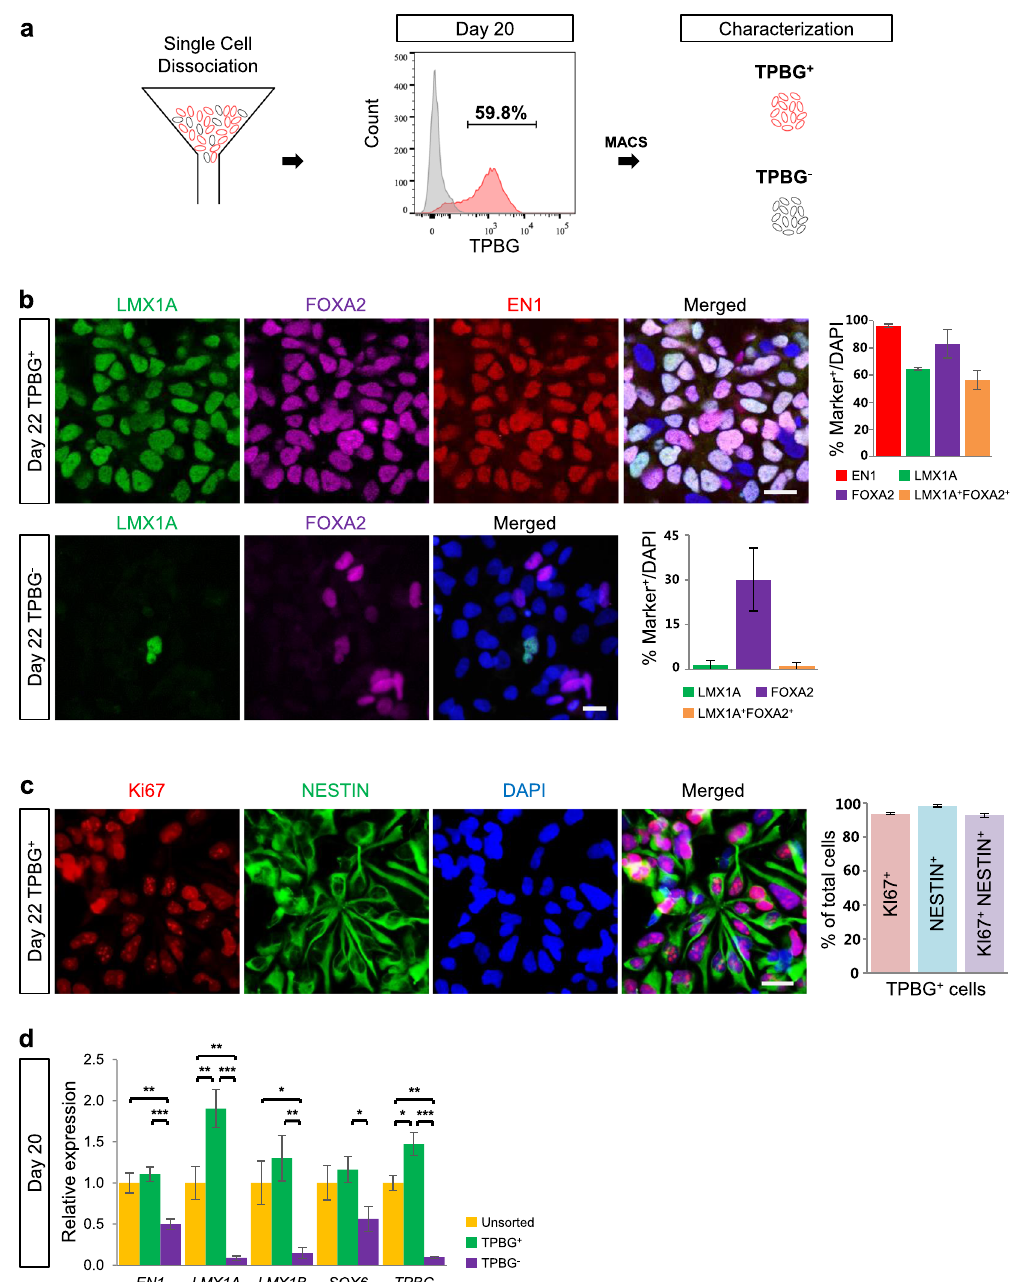
Fig. 3 Characterization of TPBG + cells. a Schematic overview of isolation and characterization of TPBG + cells on D20. b Representative immuno fl uorescence images of TPBG + cells and TPBG − cells expressing LMX1A (green), FOXA2 (magenta), and EN1 (red) two days after MACS. Cells were counterstained with DAPI (blue). The percentages of EN1 + , LMX1A + , FOXA2 + , and LMX1A + FOXA2 + double-positive cells out of the total cell population are shown in the graphs. Data are the mean ± SD of three independent experiments. c Representative immuno fl uorescence images of TPBG + cells targeting Ki67 (red), NESTIN (green), and DAPI (blue) ( left ). The percentages of NESTIN + , Ki67 + , and NESTIN + Ki67 + double-positive cells in the total cell population are shown in this graph. Data are shown as mean ± SD of three independent experiments. d Comparison of relative expression of vmDA lineage markers and regional identity markers (i.e., EN1 , LMX1A , LMX1B , and SOX6 ) on D20 among unsorted, TPBG + , and TPBG − cell populations. Values for unsorted cells were arbitrarily set to 1. Data are shown as mean ± SEM of three biological replicates. * p < 0.05, ** p < 0.01, *** p < 0.001, one-way ANOVA with Bonferroni ’ s multiple-comparison tests. Scale bars, 25 µm. MACS magnetic-activated cell